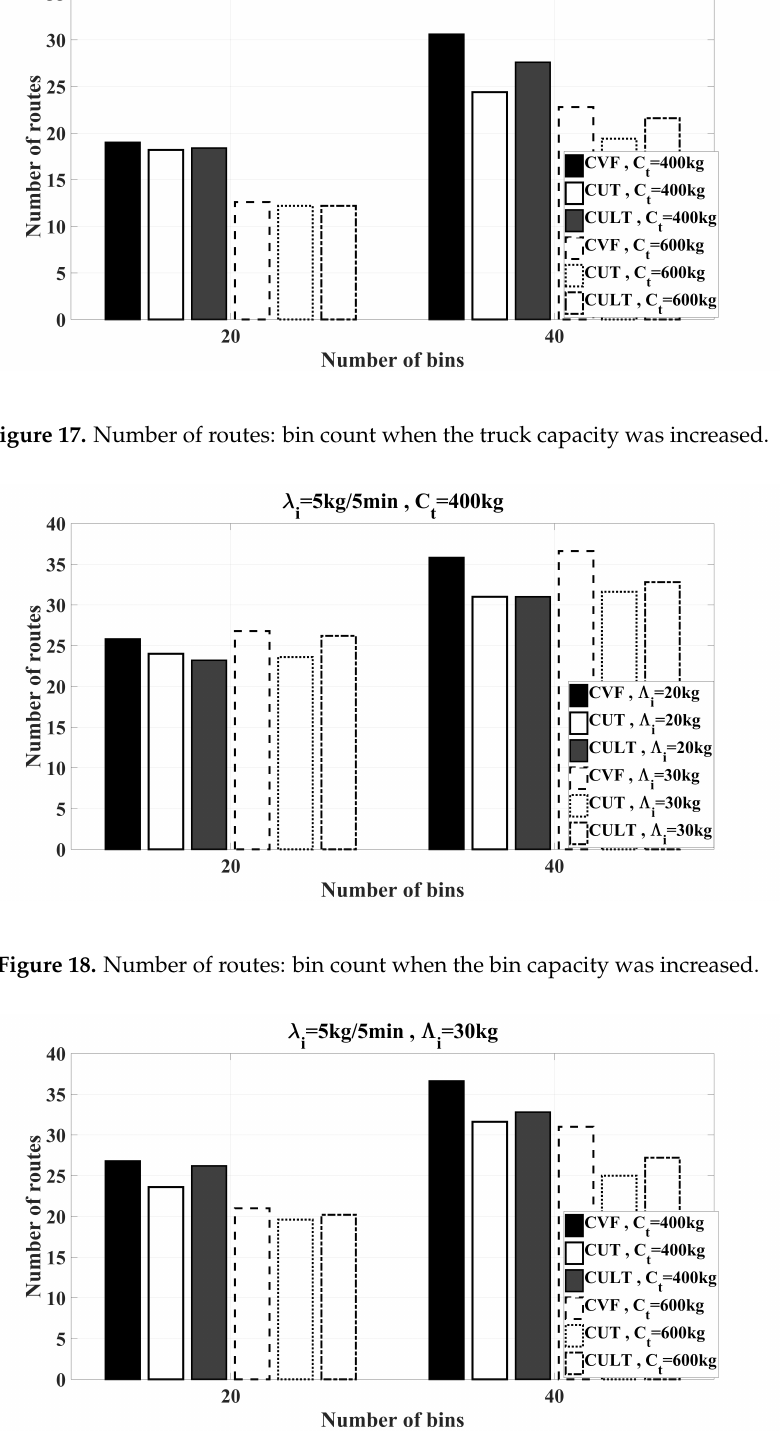
Figure 19. Number of routes: bin count when the truck capacity was